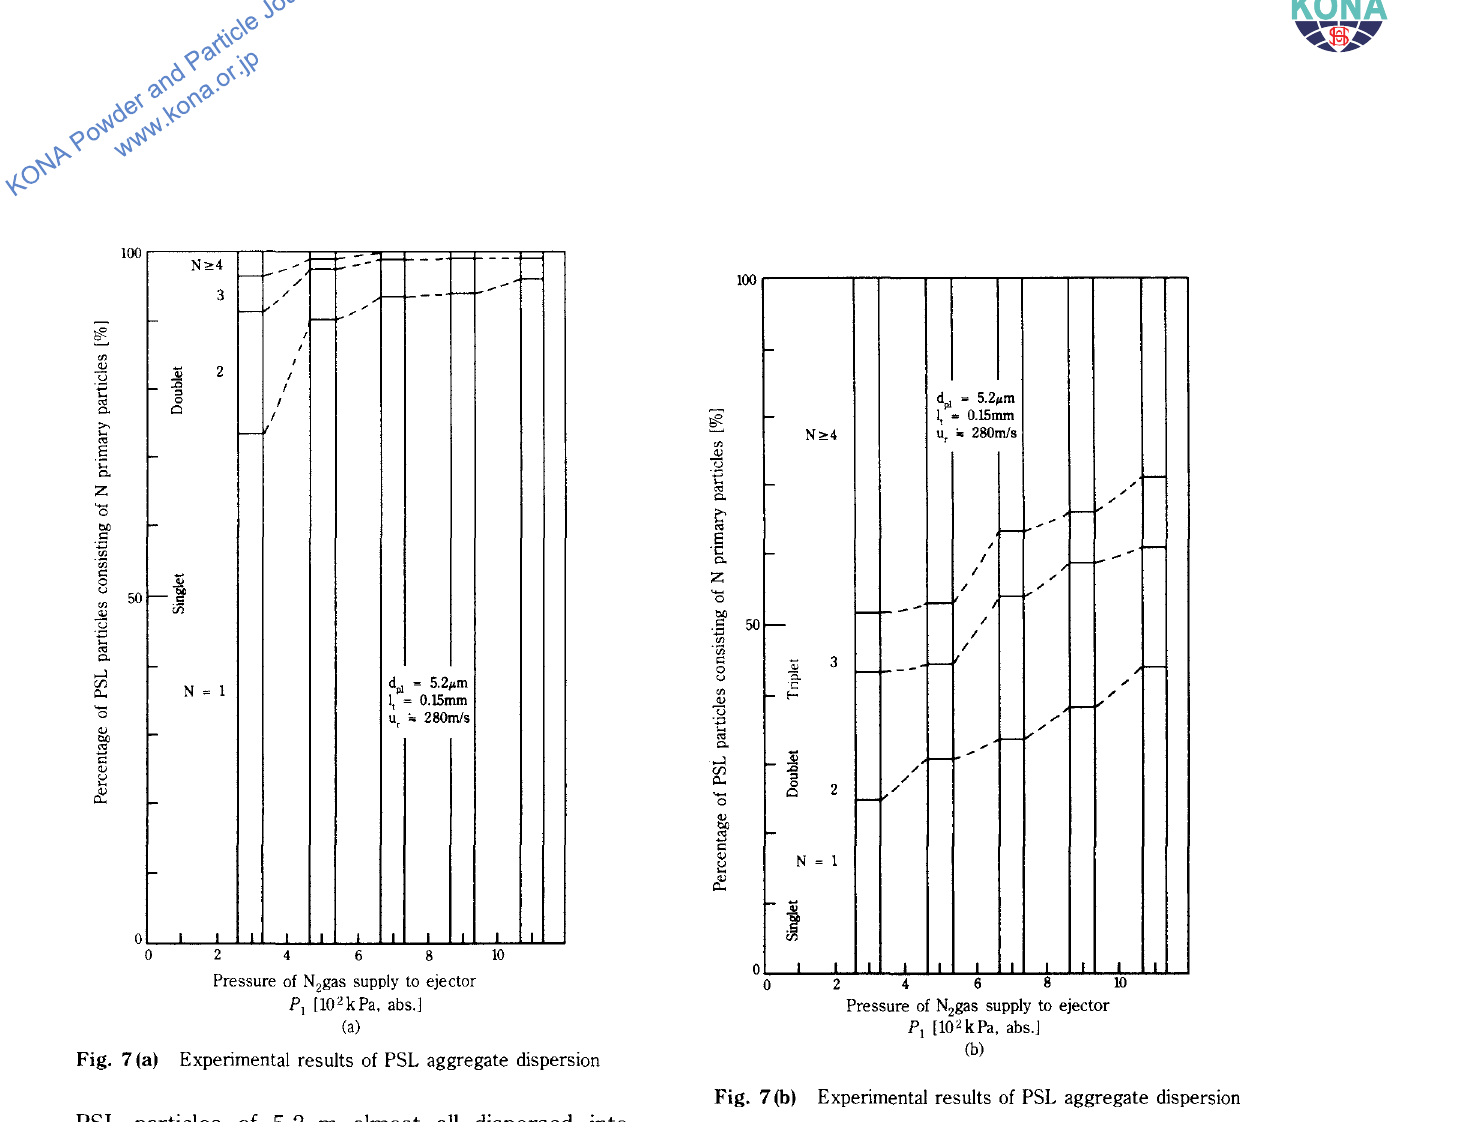
Fig. 7 (b) Experimental results of PSL aggregate